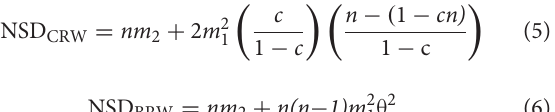
TABLE 1 | Summary statistics for 2016 (see Hoover et al., in press) and 2018 neonate tracking trials.